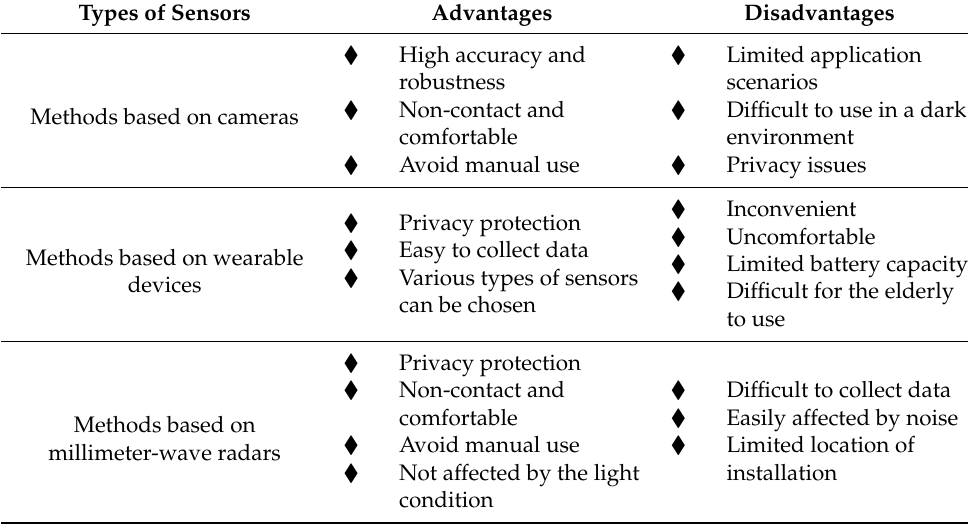
Table 1. Advantages and disadvantages of different